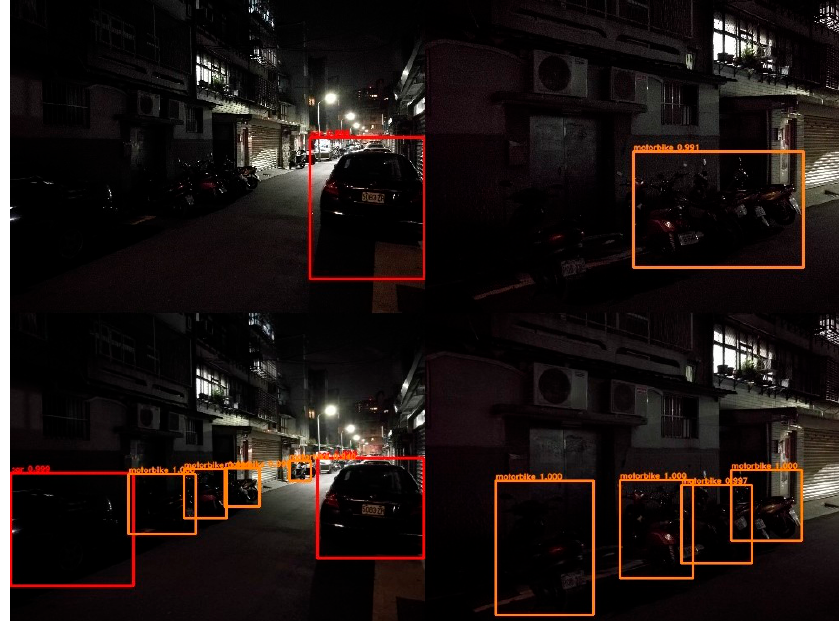
Figure 4. Extremely dark images processed by the Faster R-CNN [5] with ResNet101 [2]. Upper row : Trained with PASCAL VOC 2007 [6]. Lower row : Trained with our nighttime data. Table 1. Performance of common classes inferred by the models trained with PASCAL VOC 2007 [6] for our nighttime data.